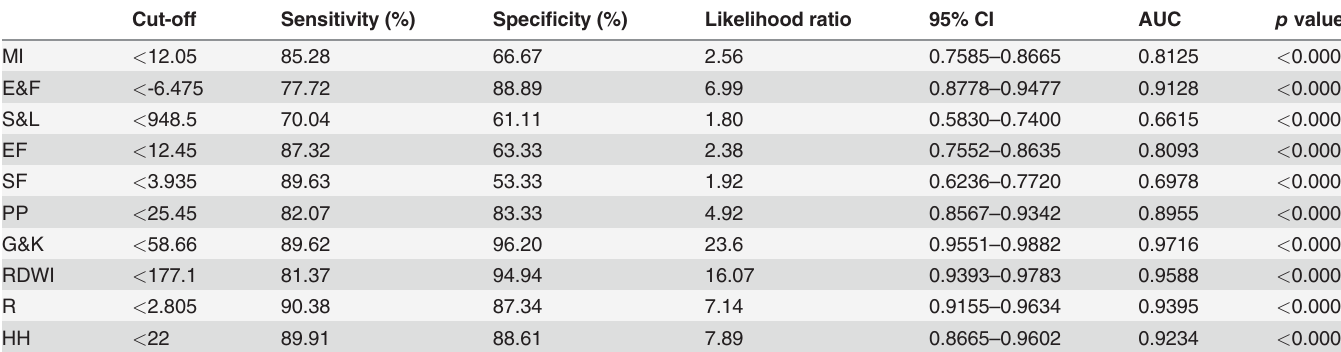
Table 4. The proposed cut-off values of different discrimination index in differentiation of thalassemia from IDA. Cut-off